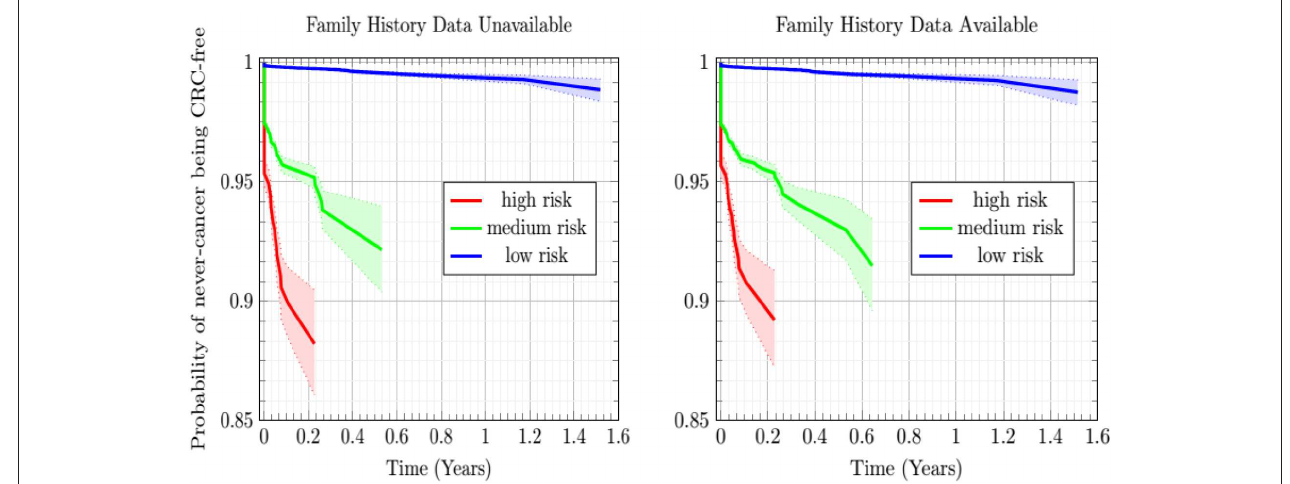
FIGURE 4 | Plot of the Kaplan-Meier estimator of the CRC-free probability of the PLCO respondents vs. time for the low-, medium-, and high CRC-risk groups stratified by ANN with EM imputation model. The shaded regions are 95% confidence intervals at TRIPOD level 1a.